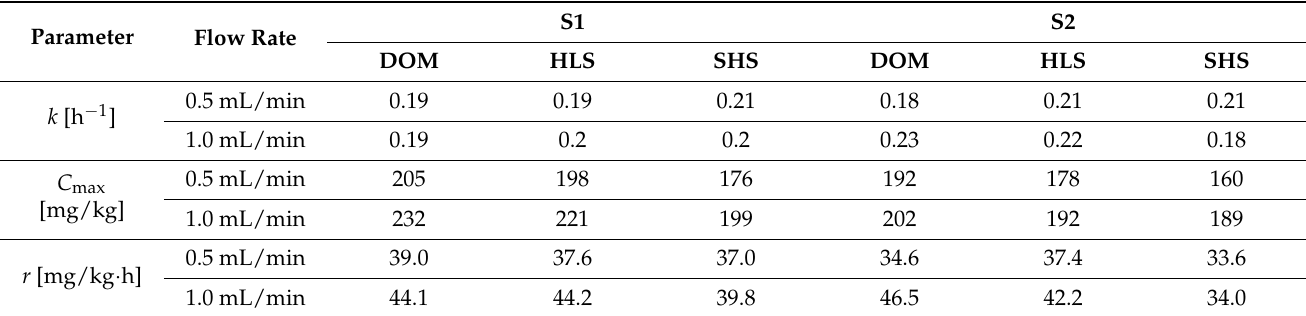
Table 1. Kinetic parameters of cumulative Cd